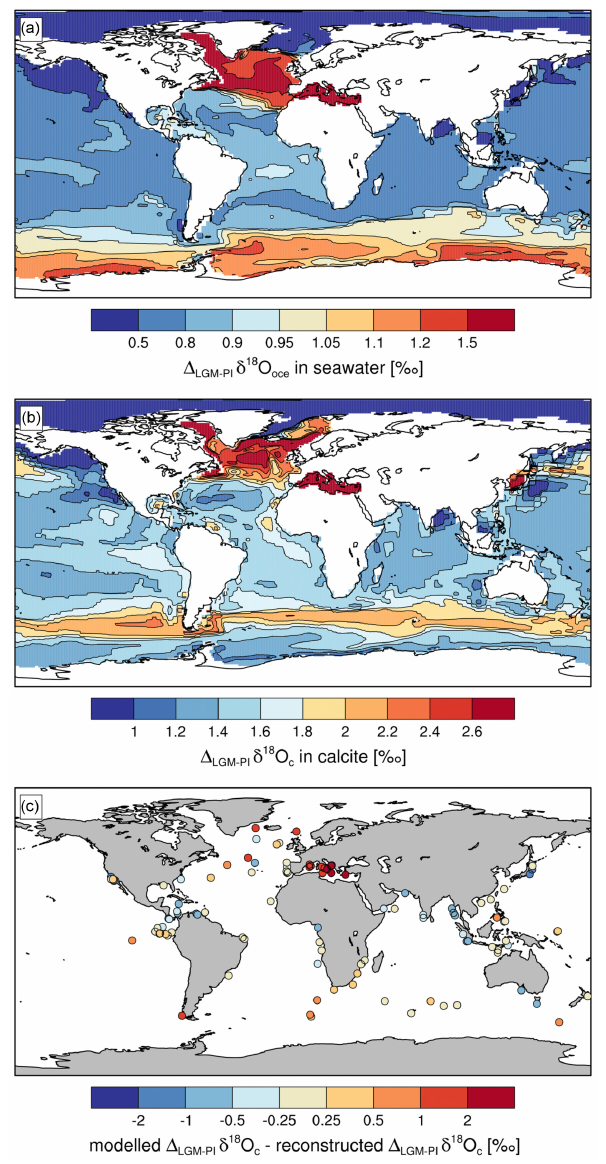
Figure 10. (a) Simulated global pattern of annual mean δ 18 O oce changes in ocean surface waters (0–50m depth) between the LGM and PI climate. (b) Calculated global pattern of annual mean δ 18 O c changes in calcite in ocean surface waters between the LGM and PI climate. The δ 18 O c values are derived from the simulated δ 18 O oce changes shown in panel (a) and the modelled LGM-PI ocean tem- perature changes (see text for details). (c) Difference between sim- ulated LGM-PI δ 18 O c changes and LGM–Late Holocene δ 18 O c anomalies of a compilation of 114 planktic foraminifera data en- tries compiled by Caley et al.